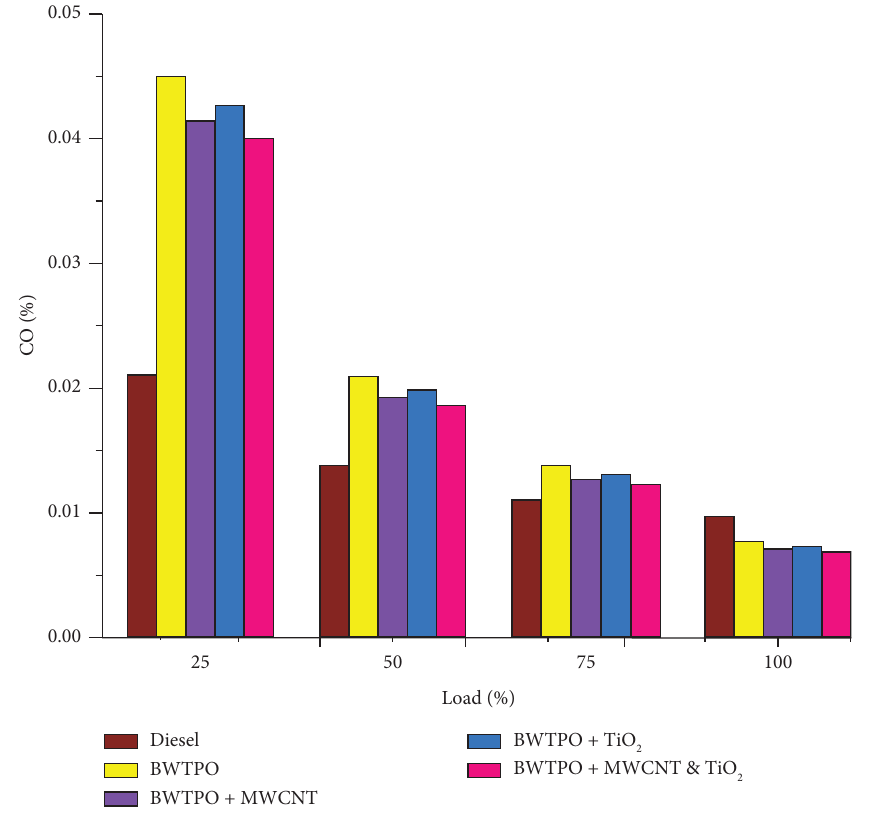
Figure 7: Relationship between CO emission (%) and load variations (%).